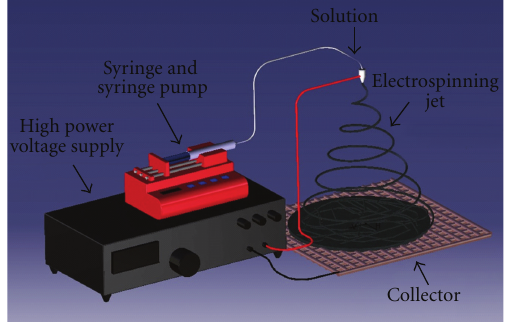
Figure 3: Diagram of electrospinning process.